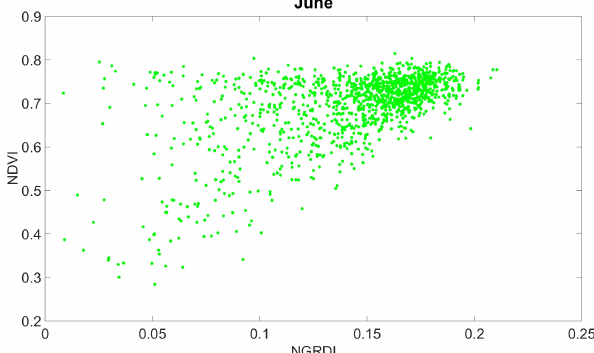
Figure B1. NGRDI from 18 June against NDVI from 22 June. NDVI seems to saturate at high values of